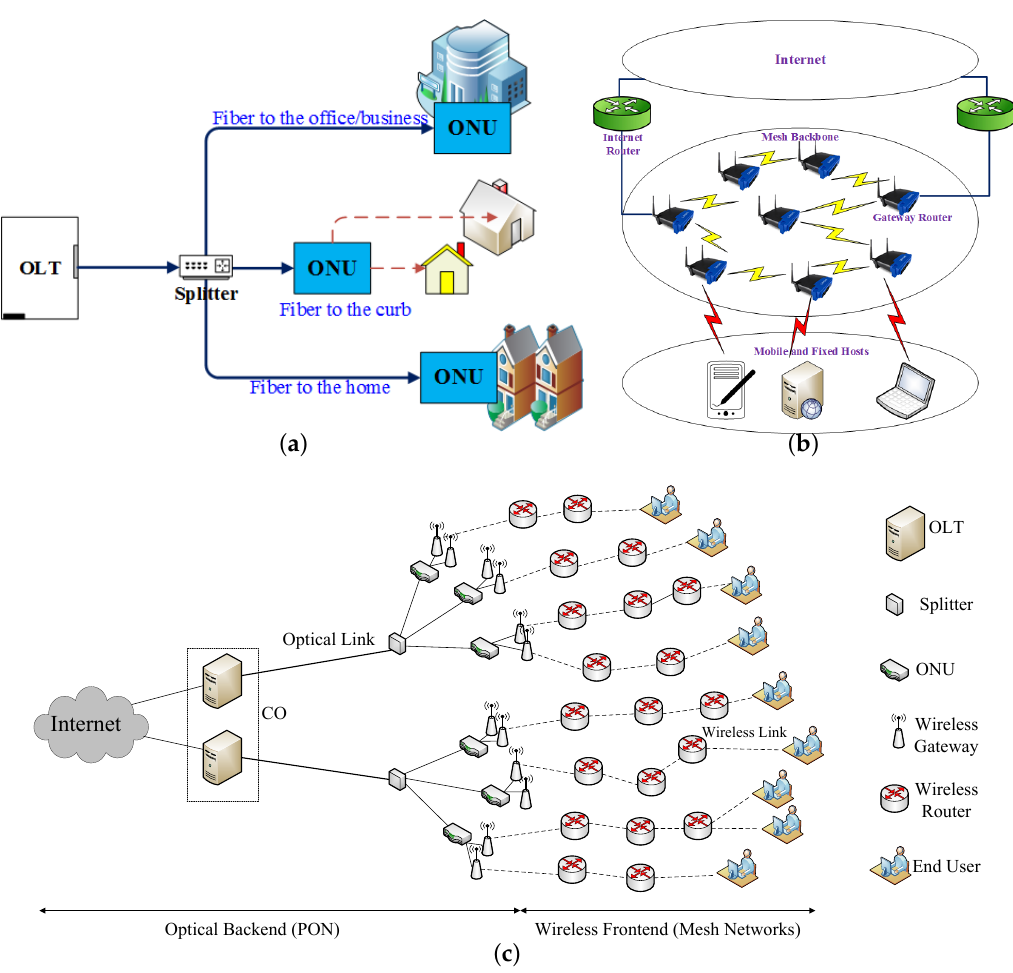
Figure 1. Access network architectures: ( a ) a PON for optical access; ( b ) a typical wireless mesh network for wireless access; ( c ) a WOBAN, which is a combination of PON and wireless